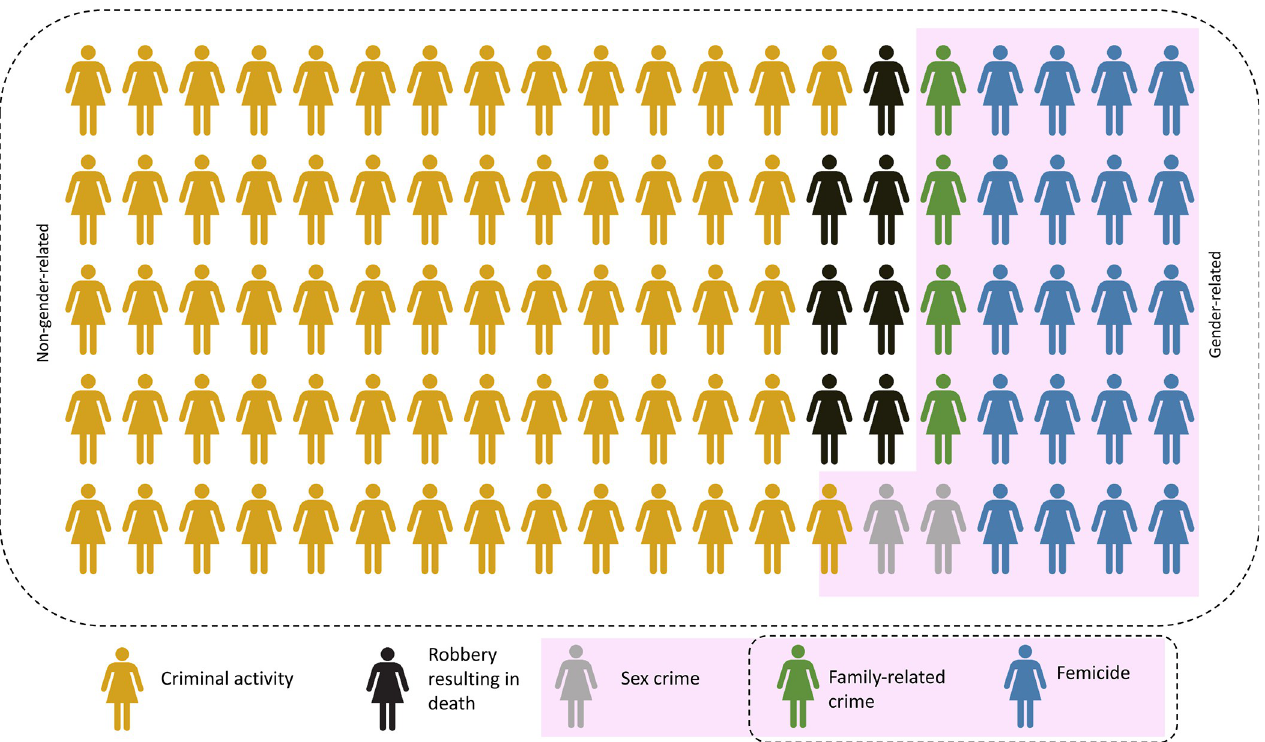
Fig 1. Proportion of female homicide according to motivation (n =